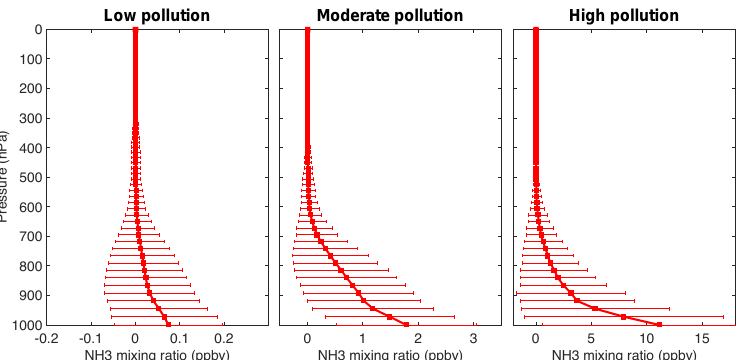
Figure 1. The a priori profiles and the square root of the diagonal terms of the error covariance matrices for the low pollution (left panel), the moderate pollution (middle panel), and the high pollution scenarios (right panel), respectively.